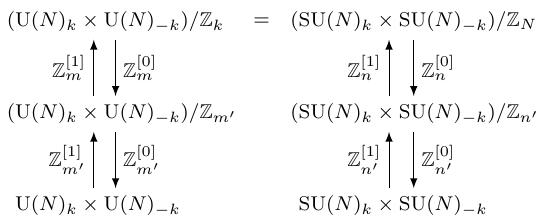
Figure 2 . The general discrete gauging relations for